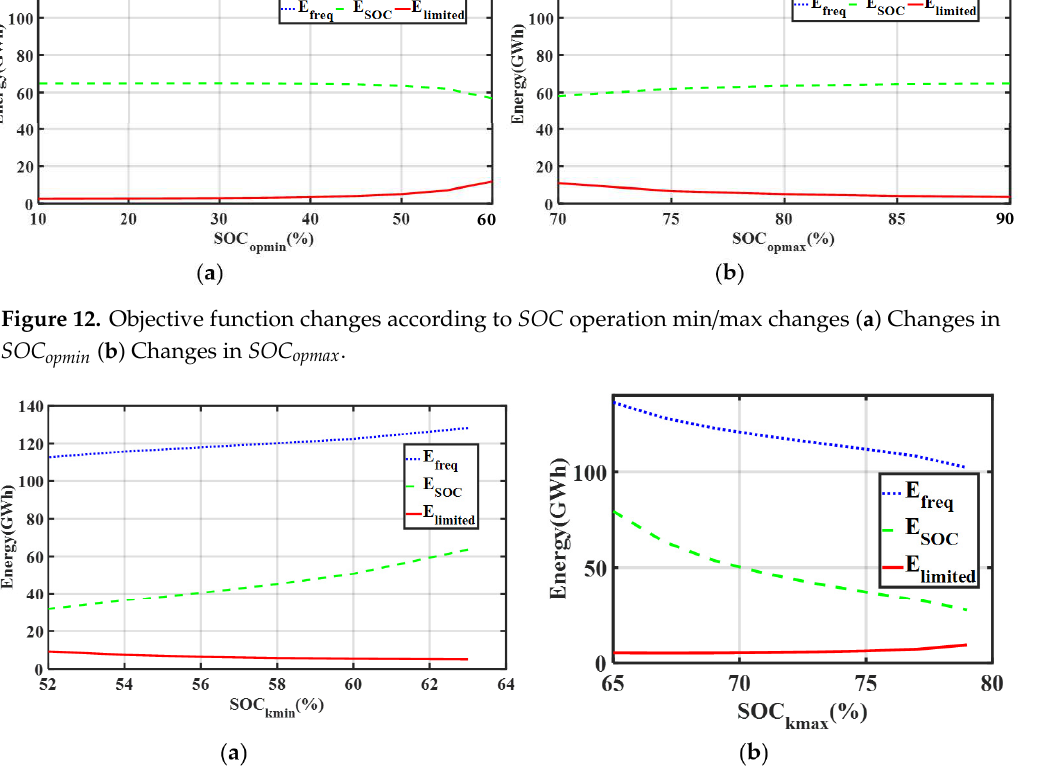
Figure 13. Objective function changes according to SOC maintaining min / max changes ( a ) Changes in SOC kmin ( b ) Changes in SOC kmax